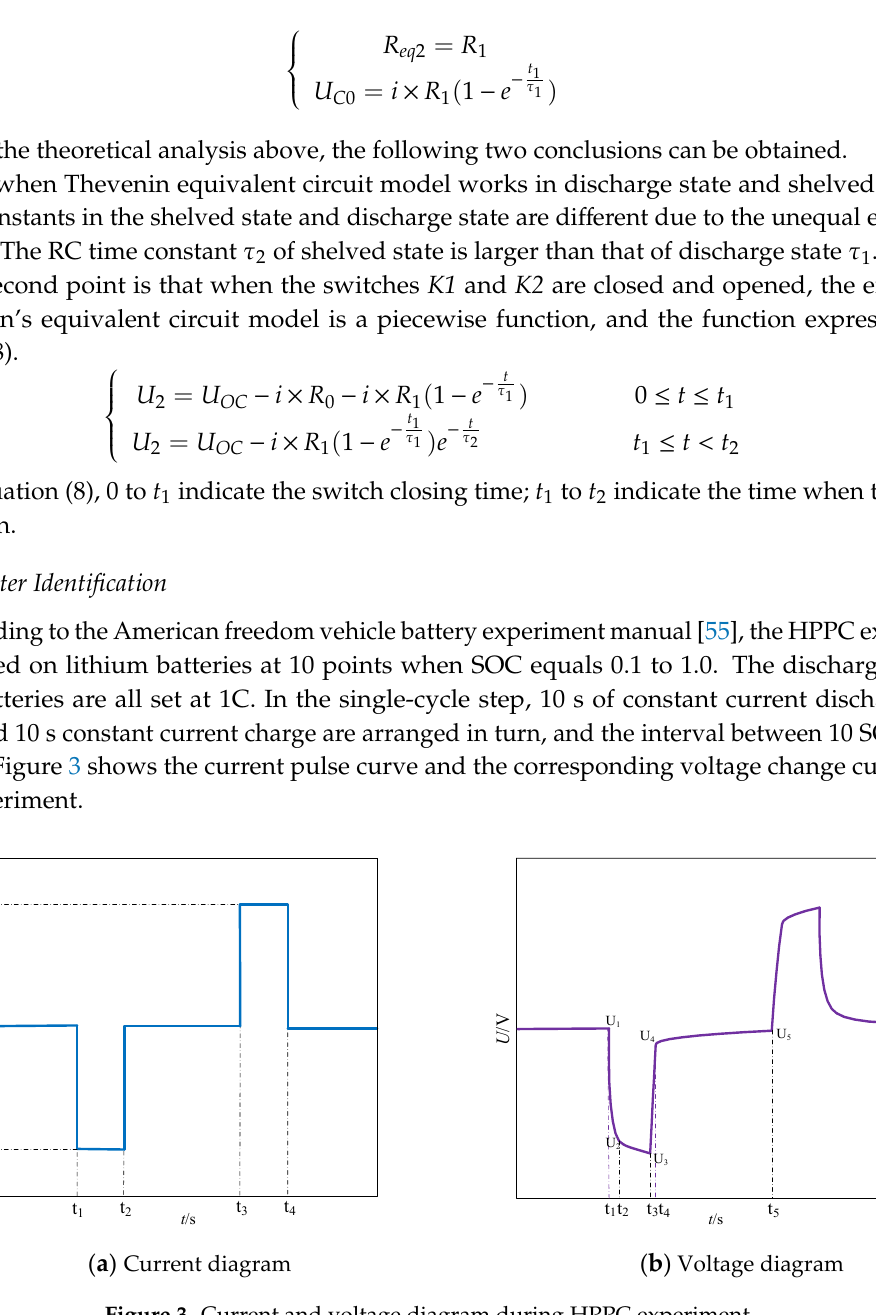
Figure 3. Current and voltage diagram during HPPC experiment.